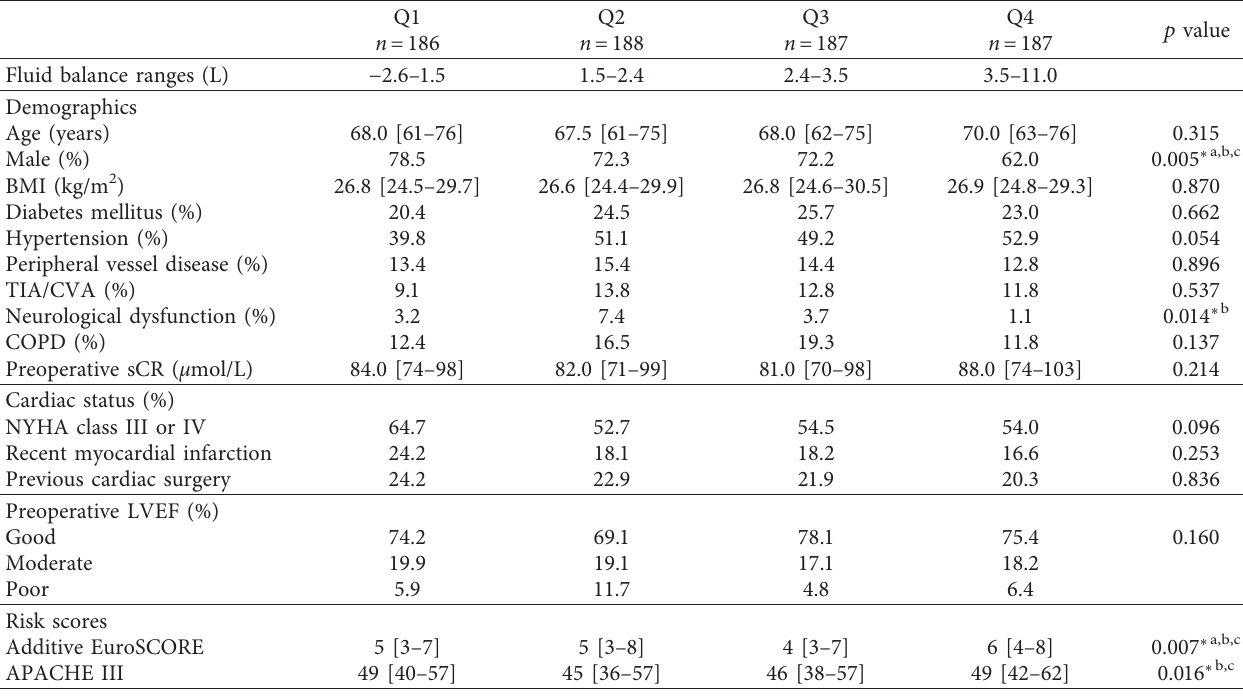
Table 1: Baseline characteristics.